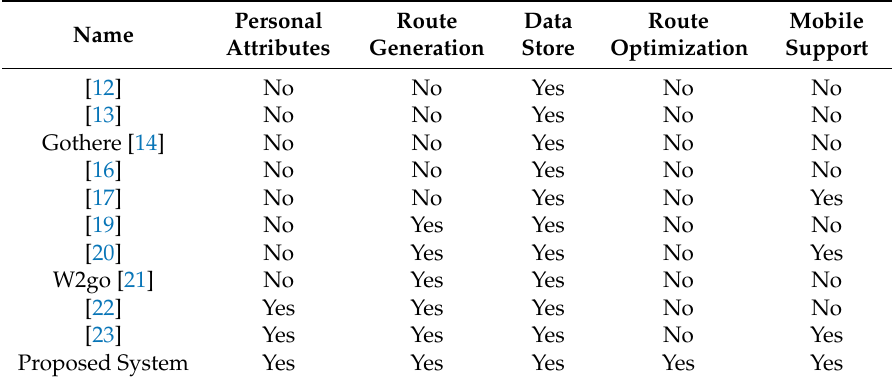
Table 8. Comparative analysis of the proposed system with the related systems.